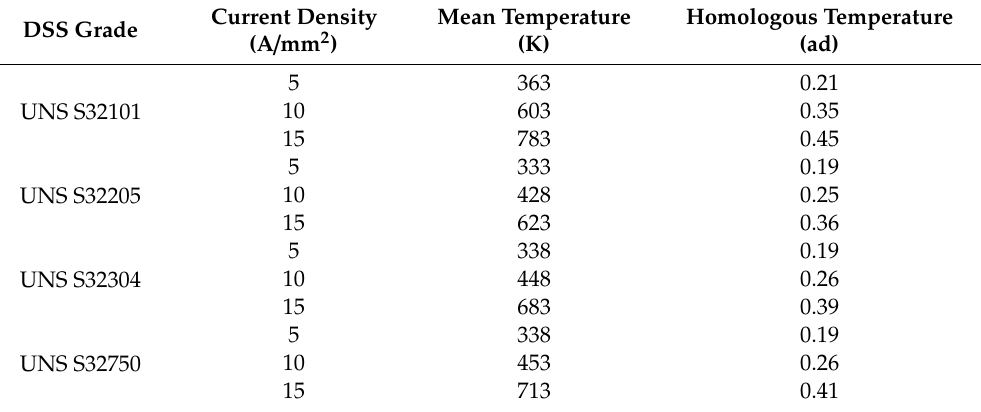
Table 3. Current density, temperature and homologous temperature of the investigated DSSs.